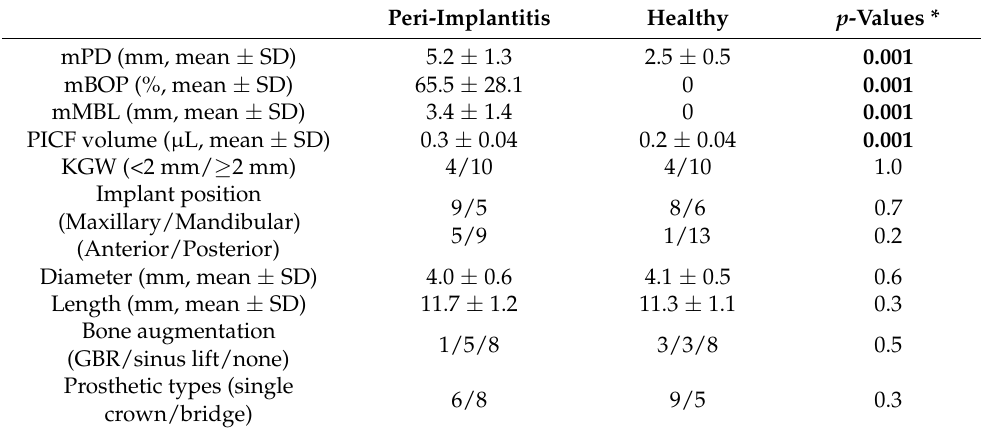
Table 1. Clinical variables of this study at implant level (N =